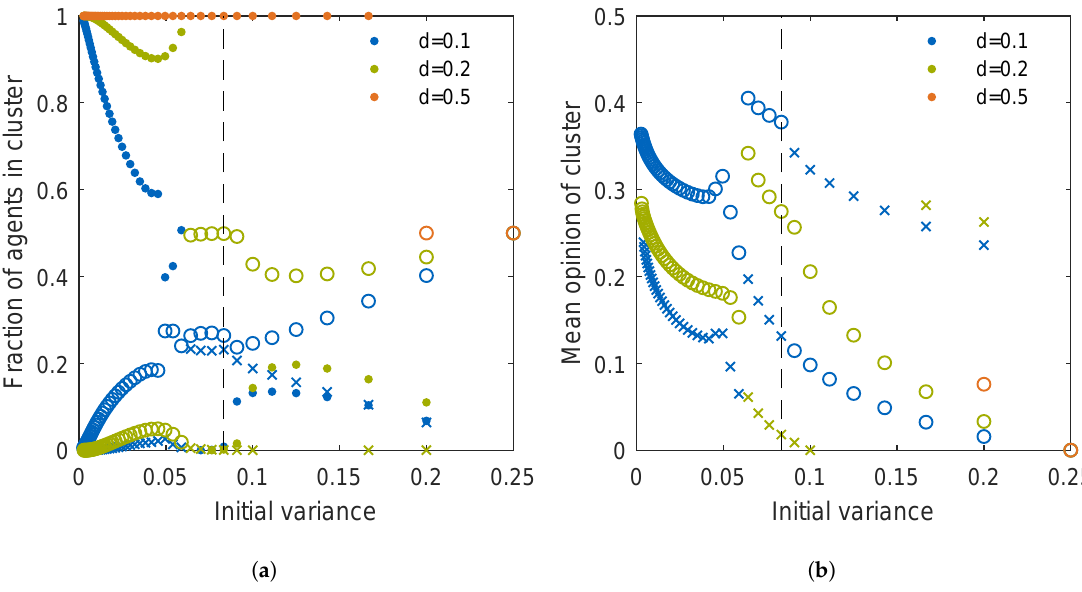
Figure 5. Fraction of agents and mean opinion of clusters over variance for three different values of bounded confidence parameter d ; points used for the cluster with mean opinion 0.5, circles for the cluster with the maximal fraction of agents, and x for the cluster with the second largest fraction of agents; the dashed line marks initially uniformly distributed belief. Results shown for fraction of agents within clusters ( a ) and mean opinion of clusters ( b